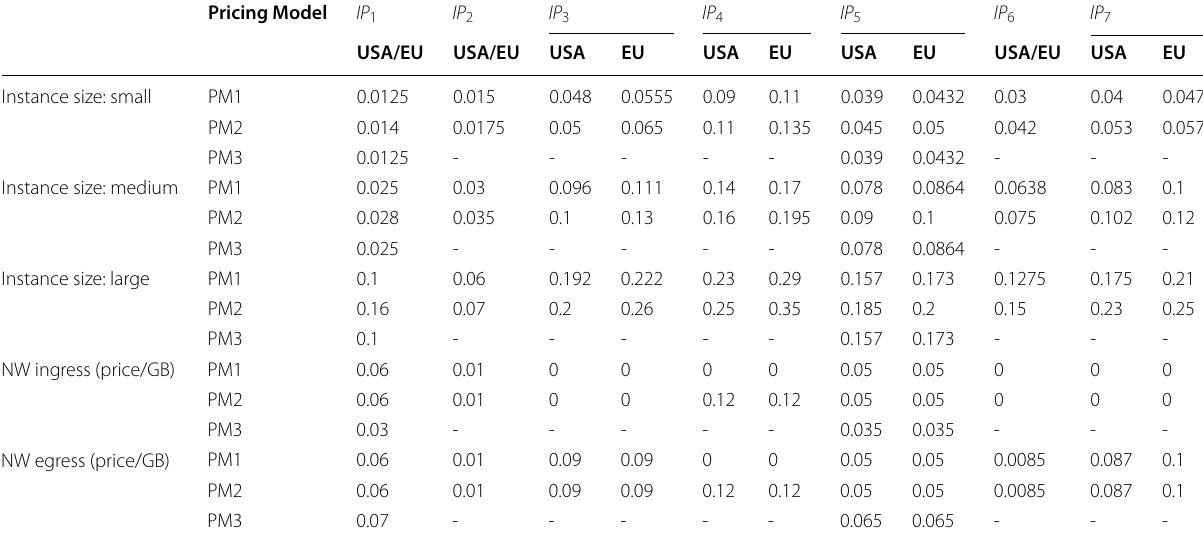
Table 11 Prices of the instance sizes and network transport (per hour, in USD) based on the choice of infrastructure provider, data centre location, and pricing